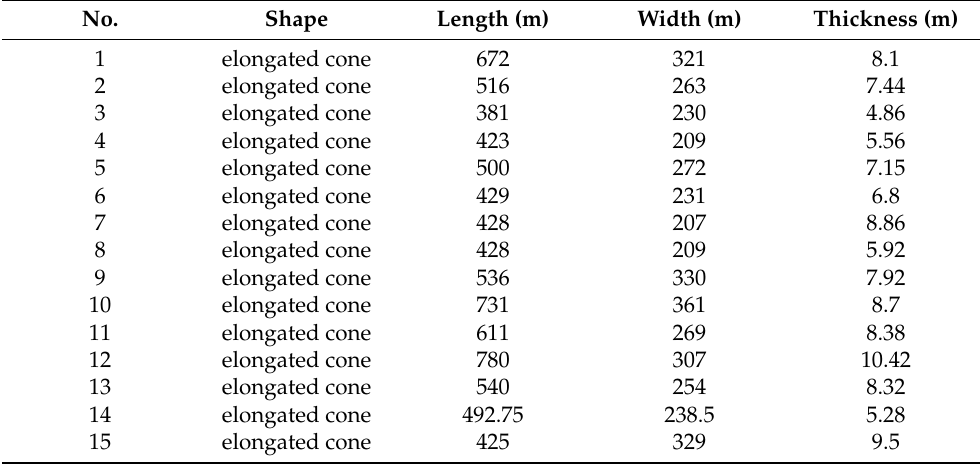
Table 2. Interpreted dimensions of sandbars in Block